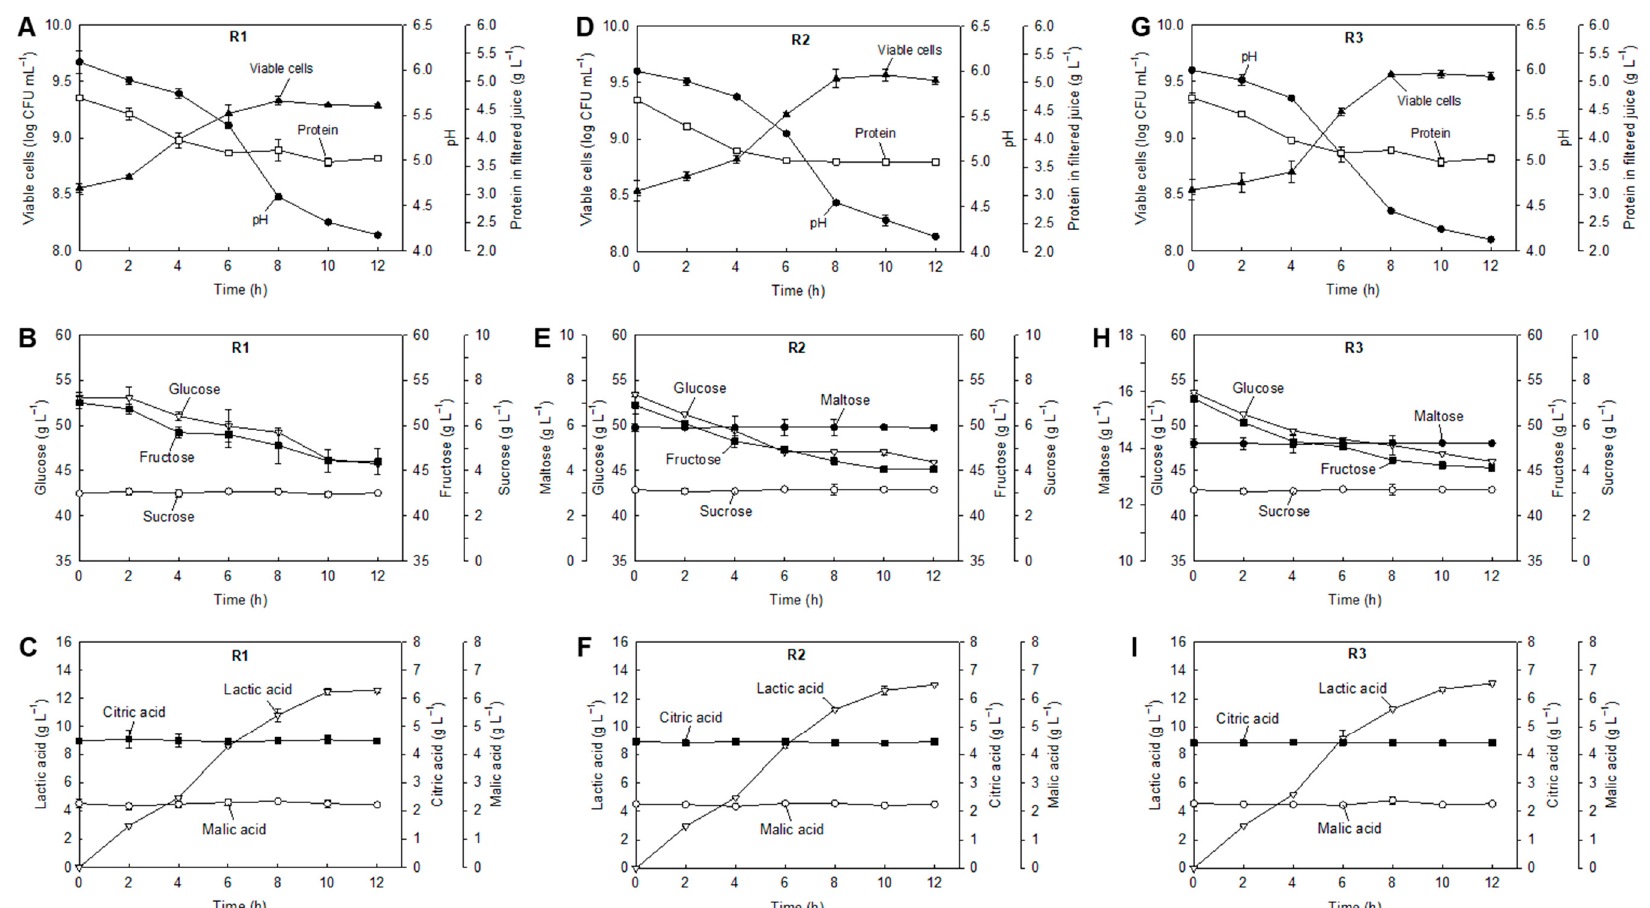
Figure 1. Anaerobic fermentation (37 °C, 12 h) profiles of Recipe 1 ( A – C ), Recipe 2 ( D – F ), and Recipe 3 ( G – I ). For each recipe, the following are shown: the viable cell counts, the pH and the protein in filtered juice ( A , D , G ); the concentrations of sugars ( B , E , H ); the concentrations of organic acids ( C , F , I ). (R1 (Recipe 1), fermented whole pineapple juice without malt extract; R2 (Recipe 2), fermented whole pineapple juice with 2% w / v of malt extract; R3 (Recipe 3), fermented whole pineapple juice with 5% w / v of malt extract.).